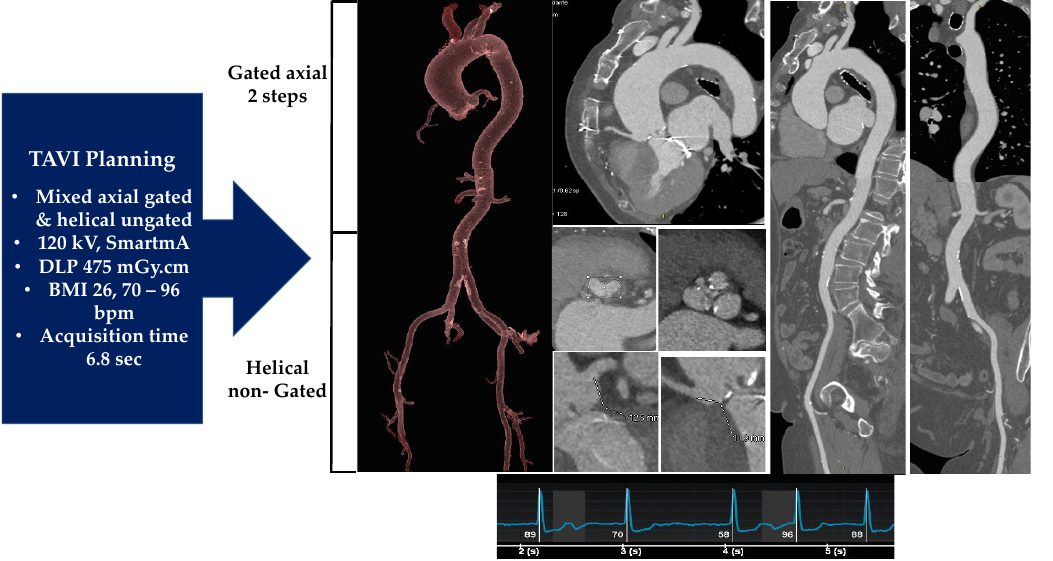
Figure 3. The 3D CT scan protocol for patients receiving TAVI. It is designed to ensure all steps of the transcatheter procedure. The figure reports an example in which the exam was conducted in 6.8 s with only 640 mGy.cm. Precise planning to support the intervention was conferred. Abbreviations; DLP, Dose Length Product; mGy,